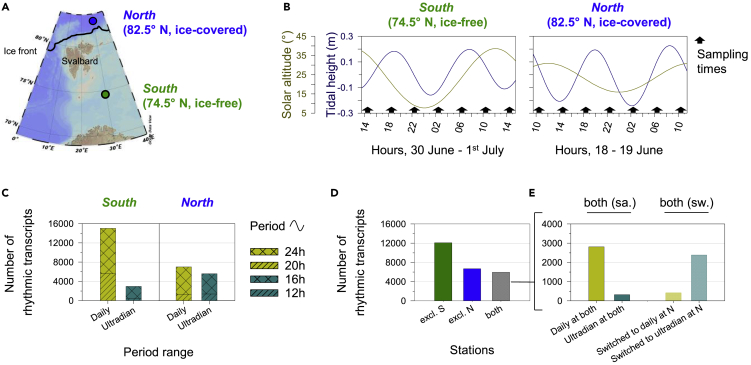
Sampling strategy and results of the rhythmic analysis at South (74.5°N, ice-free) and North (82.5°N, ice-covered) stations(A) Map with sampled stations South (74.5 °N, ice-free) and North (82.5 °N, ice-covered) and the position of the ice edge at the day of sampling at North.(B) Solar altitude above the horizon (°, dark yellow) and tidal height (m, dark blue) cycles over the sampling times at each station. Sampling of Calanus finmarchicus (indicated by black arrows) covered a complete 24h cycle at 4h intervals at each station, from the 30th June at 14-15h to 1st July at 14-15h at South (9 days after summer solstice), and from the 18th June at 10-11h to the 19th June at 10-11h at North (3 days before summer solstice). For each time point and station, RNA sequencing was performed on 3 pools of 15 CV stage C. finmarchicus. The time was indicated in hours, local time (UTC +2). C-D-E. Results of rhythmic transcripts quantification (RAIN algorithm) with an adjusted-p-value cutoff of 0.001.(C) Number of daily (20h and 24h, mustard yellow) and ultradian (12h and 16h, cyan) transcripts at each station.(D) Number of rhythmic transcripts (both daily and ultradian) exclusively at South station (“excl. S”), exclusively at North station (“excl. N″), and at both stations (“both”).(E) Details on rhythmic transcripts at both stations. On the left, rhythmic transcripts at both stations with the same period range of oscillation (“both [sa.]”): daily at both station (full mustard yellow) and ultradian at both stations (full cyan). On the right, rhythmic transcripts at both station with a switch of period range at North (“both [sw.]”): ultradian transcripts at South switching to daily at North (stripped mustard yellow) and daily transcripts at South switching to ultradian at North (stripped cyan).